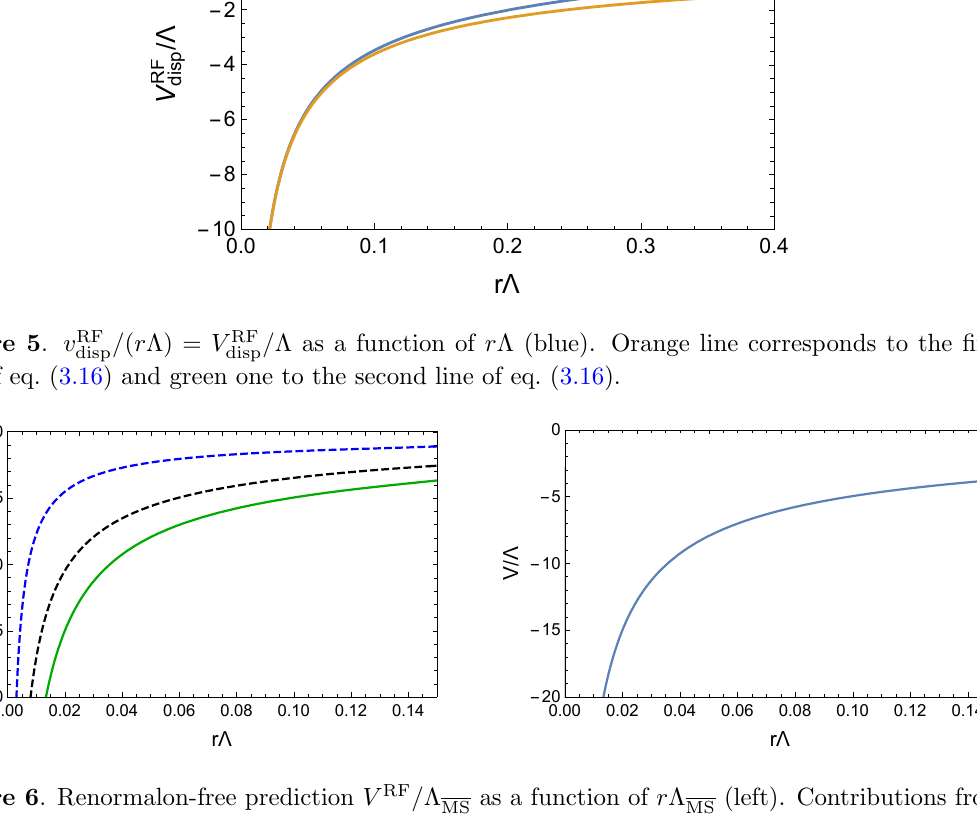
as a function of r (cid:3) (left). Contributions from MS MS